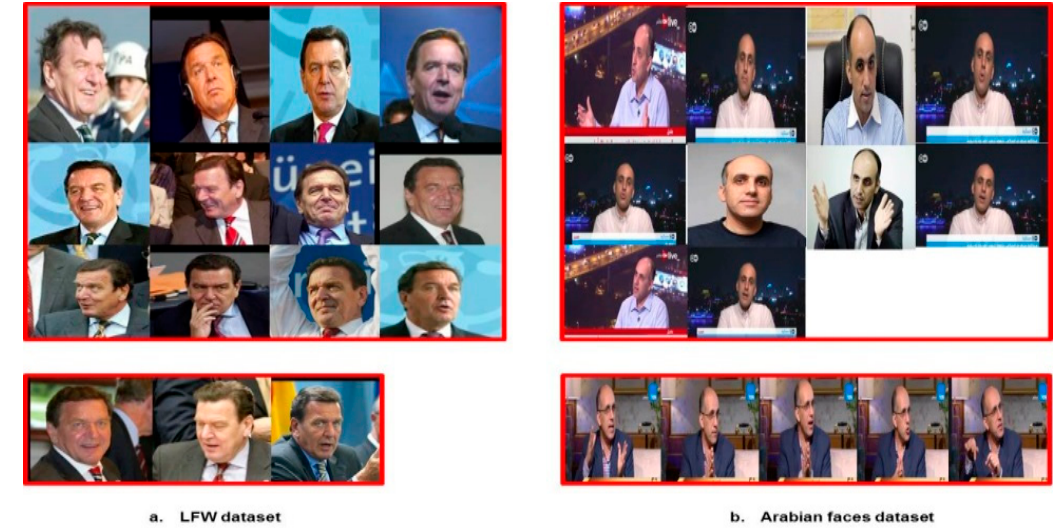
Figure 12. Sample of separated individuals, ( a ) for the LFW dataset and ( b ) for the Arabian faces dataset.